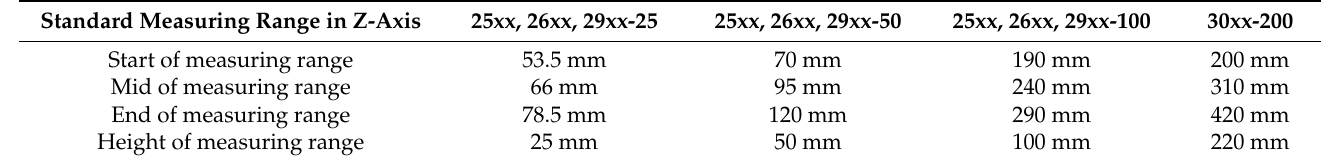
Table 2. Measuring ranges of specific sensor